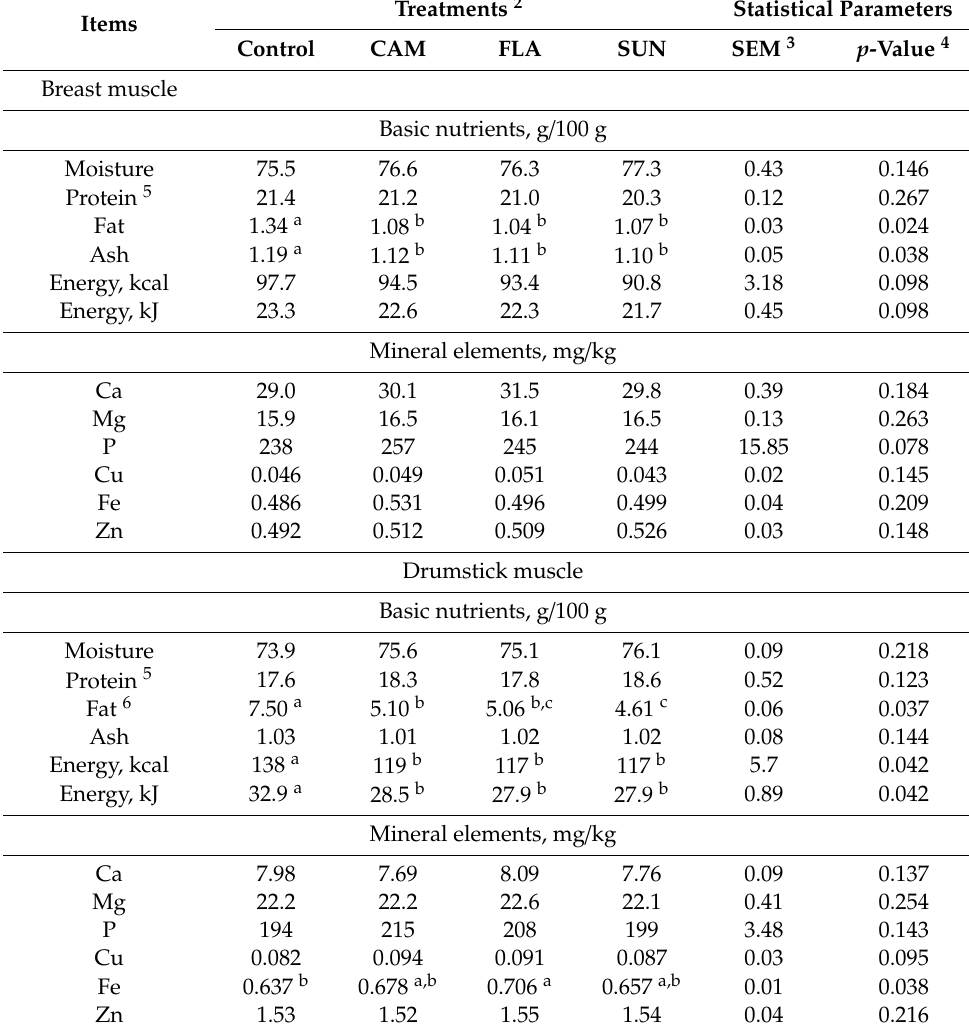
Table 5. Proximate composition, energy value, and mineral contents of meat obtained from broiler chickens fed a control, camelina, flax, and sunflower diet 1